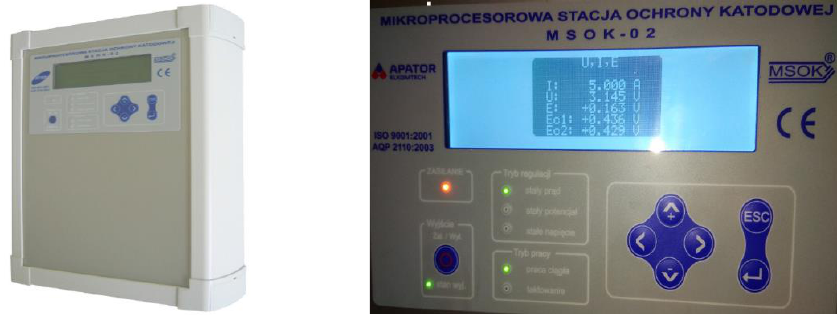
Figure 4. View of the MSOK-02 microprocessor cathodic protection station and its control panel. A schematic diagram of the polarization system is shown in Figure 5.